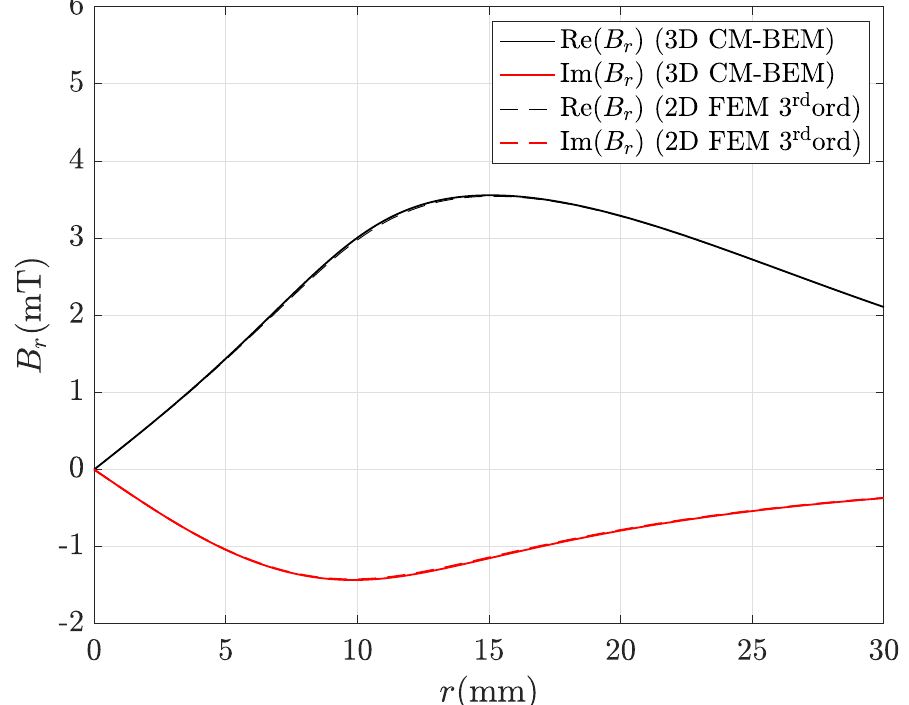
Figure 4. Real and imaginary parts of the magnetic flux density radial component B r along line A–B depicted in Figure 1 computed by the hybrid method with R-SVD matrix compression: CM-BEM is the straight line, third ord. 2D FEM (reference) is the dashed line.